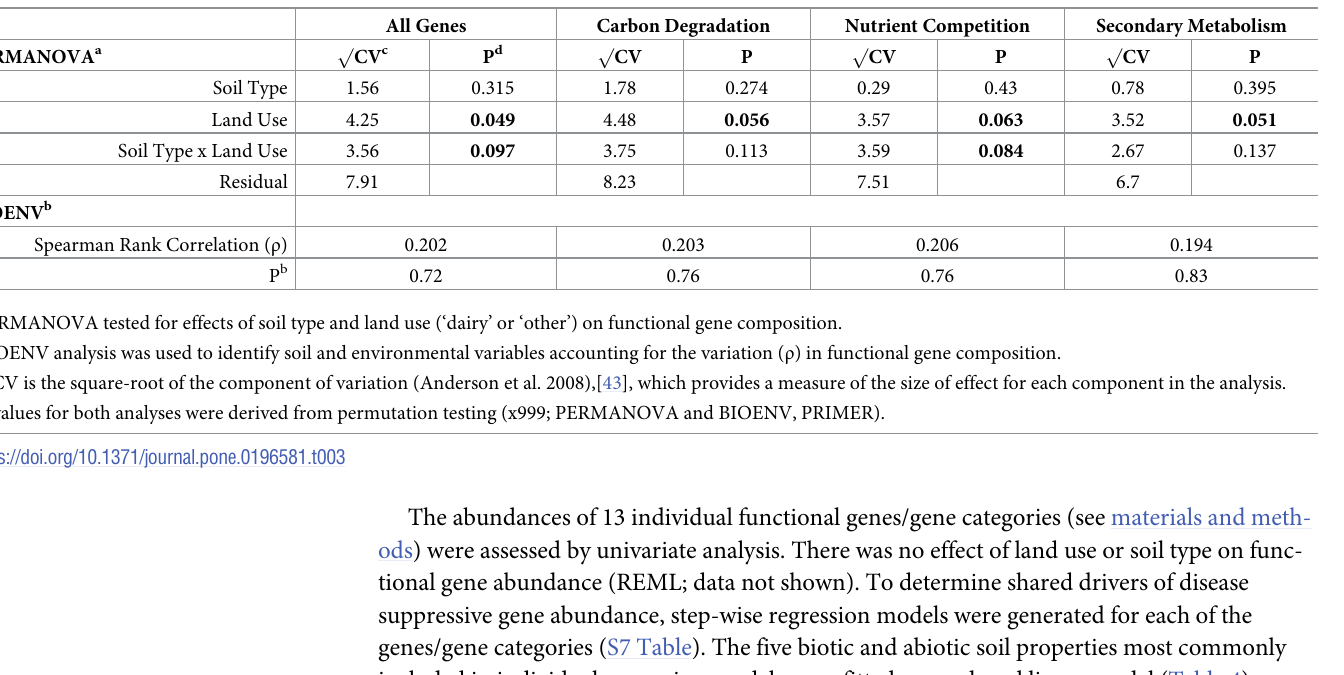
Table 3. Influence of soil type, land use and abiotic properties on the composition of disease suppressive genes.